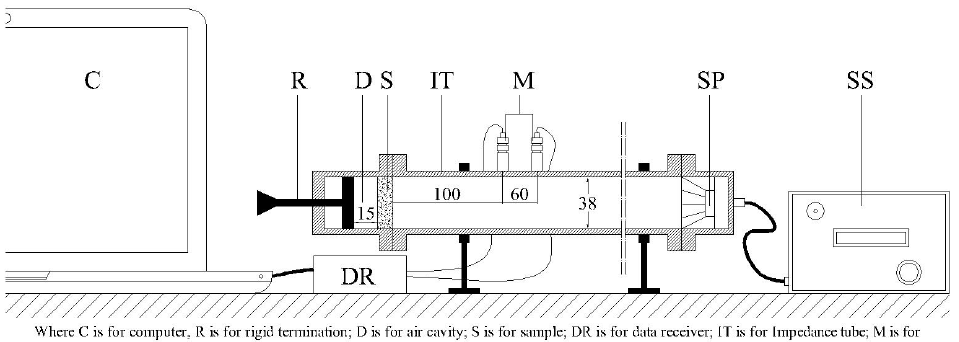
Figure 12. Impedance tube longitudinal cross-section D = 15 mm.